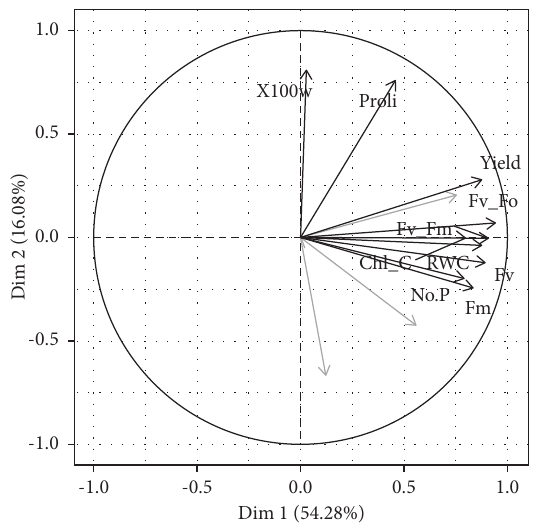
Figure 6: Variables factor map (PCA) under water stress at the reproductive stage. Proli � proline, DFL � days to flowering, RWC � relative water content, Chl_C � chlorophyll content, No.P � number of pods, Fo is the minimal fluorescence after dark adaptation, Fm is the maximal fluorescence, Fv/Fm � (Fm–Fo)/Fm is the maximum quantum yield, and Fv/Fo � (Fm–Fo)/Fo is a more sensitive plant stress detector than